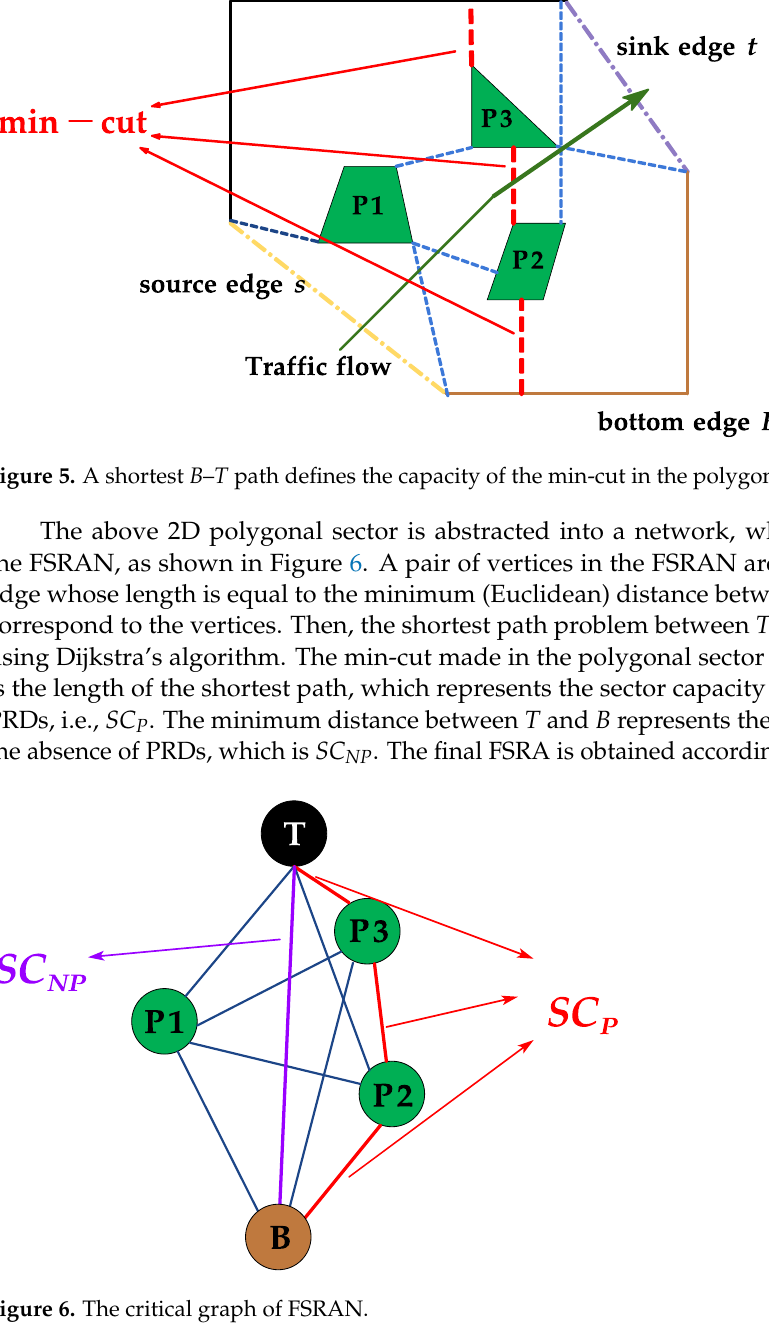
Figure 6. The critical graph of FSRAN.